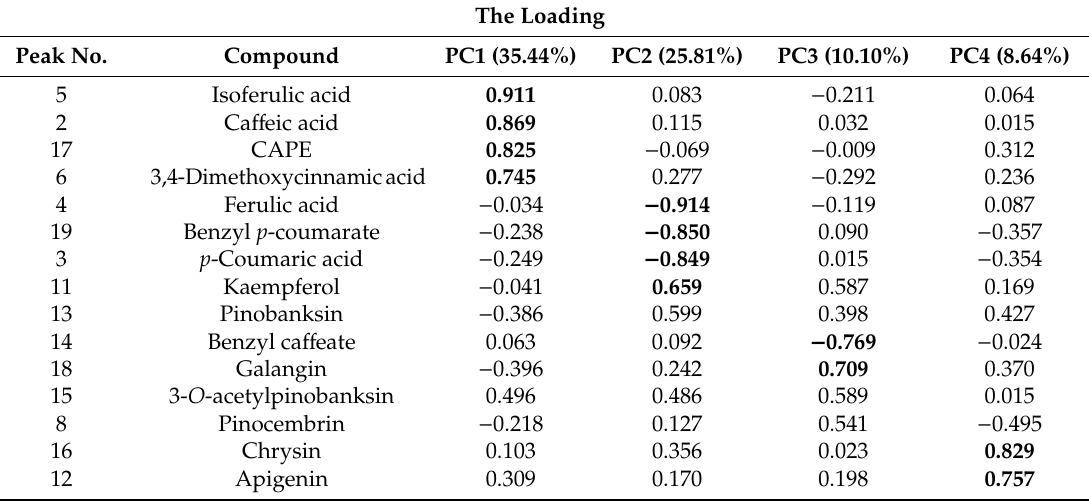
Table 3. The loadings of the first four rotated principal